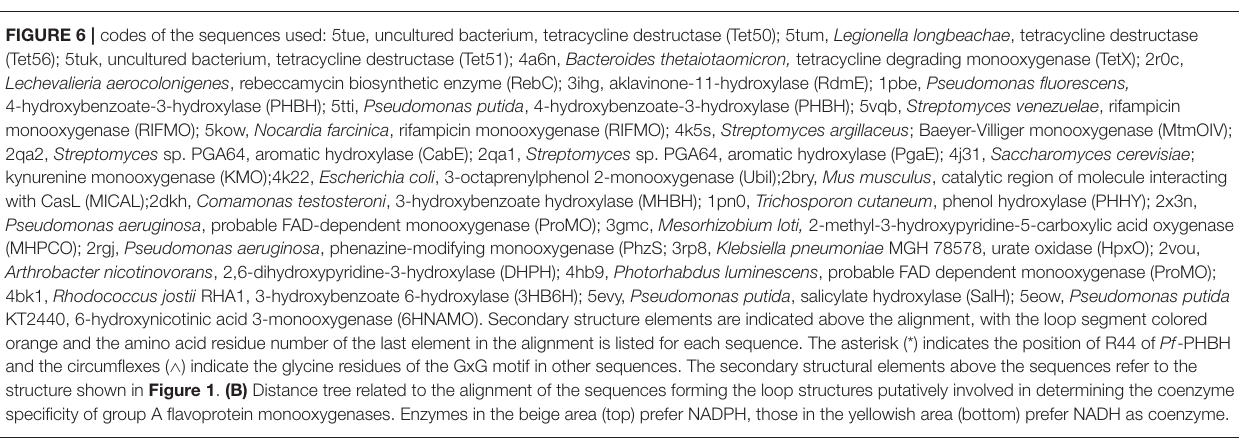
FIGURE 6 | codes of the sequences used: 5tue, uncultured bacterium, tetracycline destructase (Tet50); 5tum, Legionella longbeachae , tetracycline destructase (Tet56); 5tuk, uncultured bacterium, tetracycline destructase (Tet51); 4a6n, Bacteroides thetaiotaomicron, tetracycline degrading monooxygenase (TetX); 2r0c, Lechevalieria aerocolonigenes , rebeccamycin biosynthetic enzyme (RebC); 3ihg, aklavinone-11-hydroxylase (RdmE); 1pbe, Pseudomonas fluorescens, 4-hydroxybenzoate-3-hydroxylase (PHBH); 5tti, Pseudomonas putida , 4-hydroxybenzoate-3-hydroxylase (PHBH); 5vqb, Streptomyces venezuelae , rifampicin monooxygenase (RIFMO); 5kow, Nocardia farcinica , rifampicin monooxygenase (RIFMO); 4k5s, Streptomyces argillaceus ; Baeyer-Villiger monooxygenase (MtmOIV); 2qa2, Streptomyces sp. PGA64, aromatic hydroxylase (CabE); 2qa1, Streptomyces sp. PGA64, aromatic hydroxylase (PgaE); 4j31, Saccharomyces cerevisiae ; kynurenine monooxygenase (KMO);4k22, Escherichia coli , 3-octaprenylphenol 2-monooxygenase (UbiI);2bry, Mus musculus , catalytic region of molecule interacting with CasL (MICAL);2dkh, Comamonas testosteroni , 3-hydroxybenzoate hydroxylase (MHBH); 1pn0, Trichosporon cutaneum , phenol hydroxylase (PHHY); 2x3n, Pseudomonas aeruginosa , probable FAD-dependent monooxygenase (ProMO); 3gmc, Mesorhizobium loti, 2-methyl-3-hydroxypyridine-5-carboxylic acid oxygenase (MHPCO); 2rgj, Pseudomonas aeruginosa , phenazine-modifying monooxygenase (PhzS; 3rp8, Klebsiella pneumoniae MGH 78578, urate oxidase (HpxO); 2vou, Arthrobacter nicotinovorans , 2,6-dihydroxypyridine-3-hydroxylase (DHPH); 4hb9, Photorhabdus luminescens , probable FAD dependent monooxygenase (ProMO); 4bk1, Rhodococcus jostii RHA1, 3-hydroxybenzoate 6-hydroxylase (3HB6H); 5evy, Pseudomonas putida , salicylate hydroxylase (SalH); 5eow, Pseudomonas